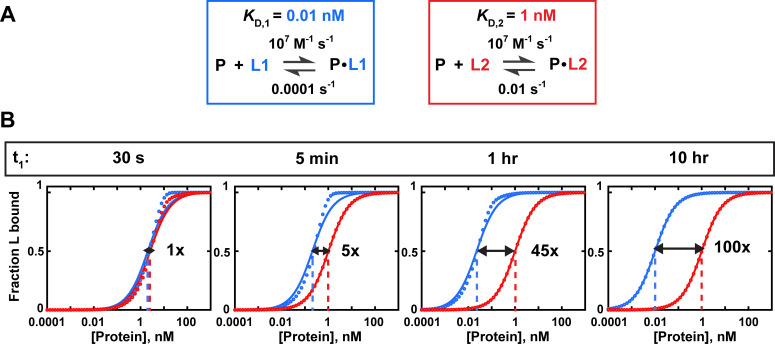
Insufficient equilibration times can lead to incorrect determination of relative affinities.(A) Binding parameters for protein (P) interactions with two ligands, L1 and L2. The dissociation rate constant (koff) for L1 is 100-fold lower than for L2, such that L1 requires much longer to equilibrate than L2 (Equation 2). (B) Simulated binding data for L1 and L2 with varying incubation times (t1). The binding to each ligand is measured individually with trace amounts of L1 (blue) or L2 (red). Solid lines are fits to an equilibrium binding equation (Equation 4b), with dashed lines indicating the protein concentration at which half of the ligand is bound. Because equilibration of L1 binding is not complete until t1 = 10 hr (while L2 equilibration only takes ~5 min), the observed relative affinity (KDapp(rel) = KD,2app/KD,1app) is time-dependent and underestimates the true specificity if the incubation time is shorter than ~10 hr. Arrows and numbers indicate KDapp(rel) values at each time point. Note the systematic deviations of the simulated data from the fit curve in cases where equilibrium has not been reached. The presence of such deviations in experimental data indicates the need for additional controls to establish equilibration and rule out titration.